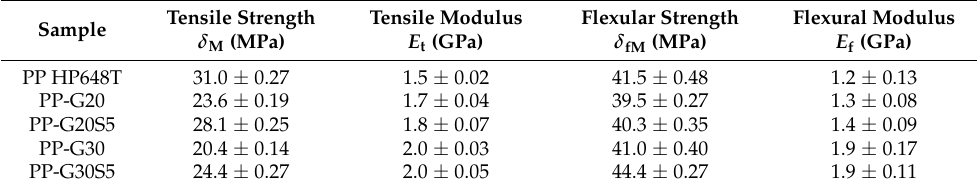
Table 6. Tensile and flexular properties of PP/grass composites Sample